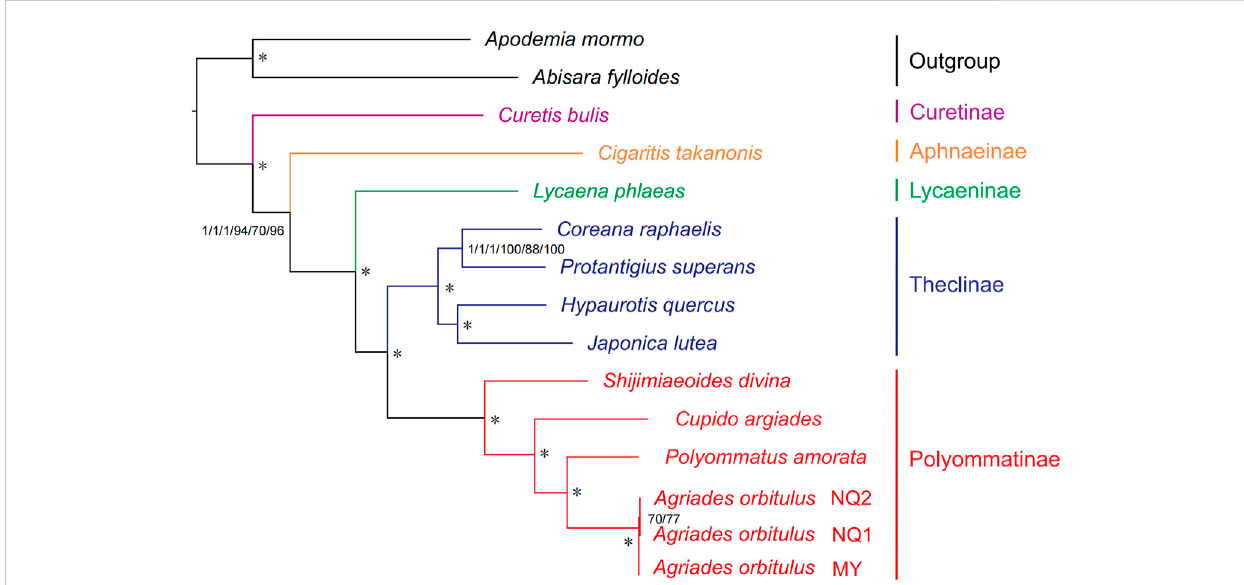
FIGURE 10 Phylogenetic relationships among fi ve subfamilies within Lycaenidae inferred from mitogenomic data. Numbers from left to right are Bayesian posterior probabilities (PP) and ML bootstrap (BS) values for each of the three datasets (P123, P123AA, and P123RNA). Asterisk (*) indicates PP = 1.0 and BS > 90. Full phylogenetic results are provided in Supplementary Figure S3.